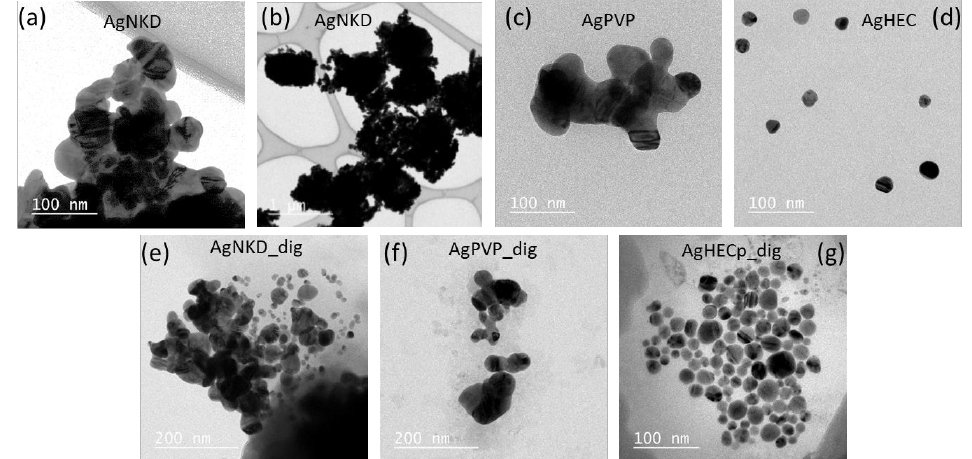
Figure 2. TEM images of non-digested and digested Ag NMs. Non-digested AgNKD, 0.2 mg/mL in DI H 2 O ( a , b ); AgPVP, 10 mg/mL in DI H 2 O ( c ); AgHECp, 0.1 mg/mL in DI H 2 O ( d ). Digested AgNKD ( e ), AgPVP ( f ), digested AgHECp ( g ), all 1 mg/mL in OGI fluid.